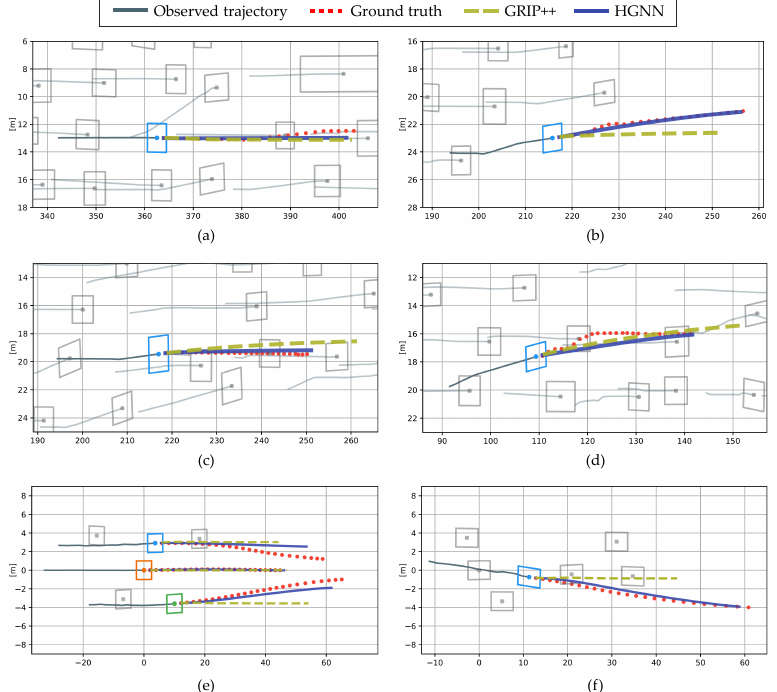
Figure 11. Visualization of the predicted trajectory. ( a – d ) The results of the NGSIM dataset, and ( e , f ) the results of the real driving